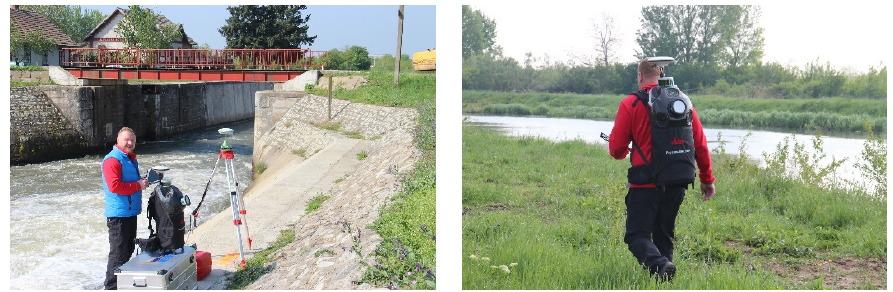
Figure 5. Static setup of the backpack for scanning and dynamic initialization-Sânmihaiu Român. 2.